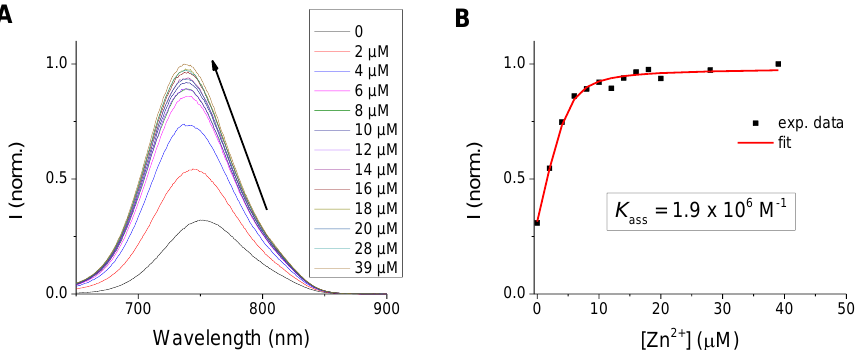
Figure 6. ( A ) Emission spectra and ( B ) corresponding changes in the total emission of 1 (5 µM), in the presence of increasing amounts of Zn 2+ . Conditions: MeOH:MOPS 10 mM pH7 (50:50); λ exc = 620 nm.